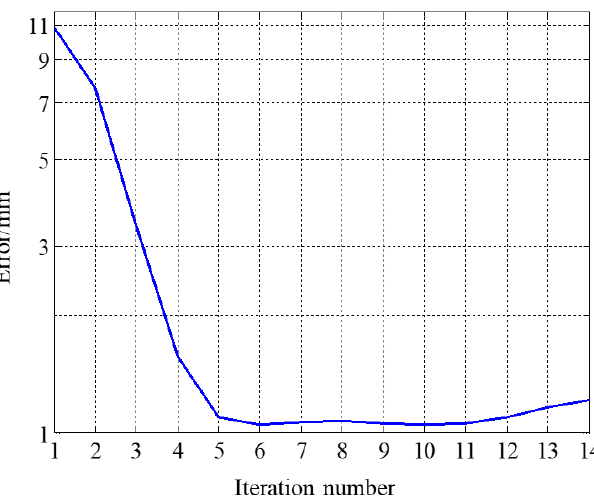
Figure 11. The errors of localization results at each iteration.